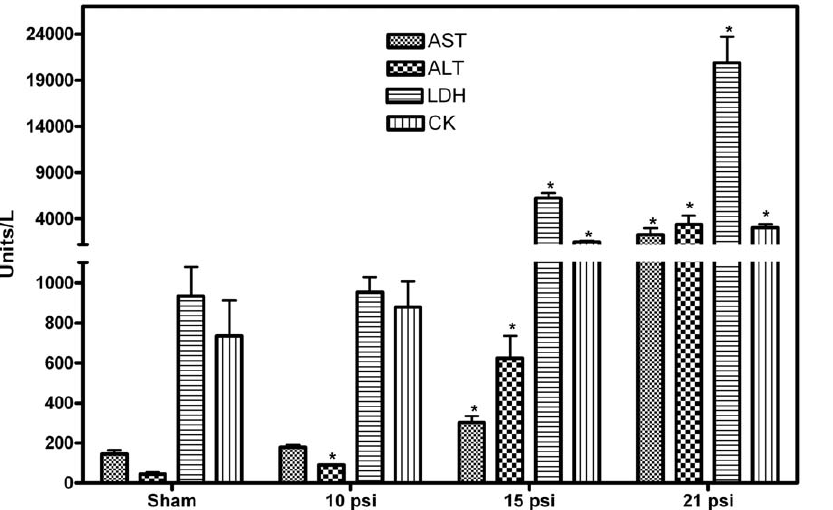
Figure 1. Blast overpressure dose response on the activities of enzymes in the plasma after 1 h. The activities of AST, ALT, LDH and CK increases in the plasma in an overpressure dose dependant manner. Mean 6 SEM values of enzyme activities after exposure to different levels of blast overpressures are compared to sham. Statistical analysis was carried out by ANOVA test (n=6). * p , 0.05.